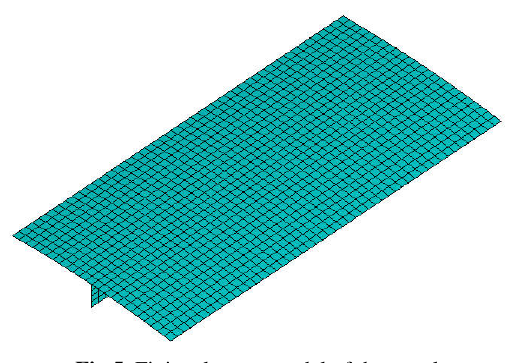
Fig 5. Finite element model of the panel